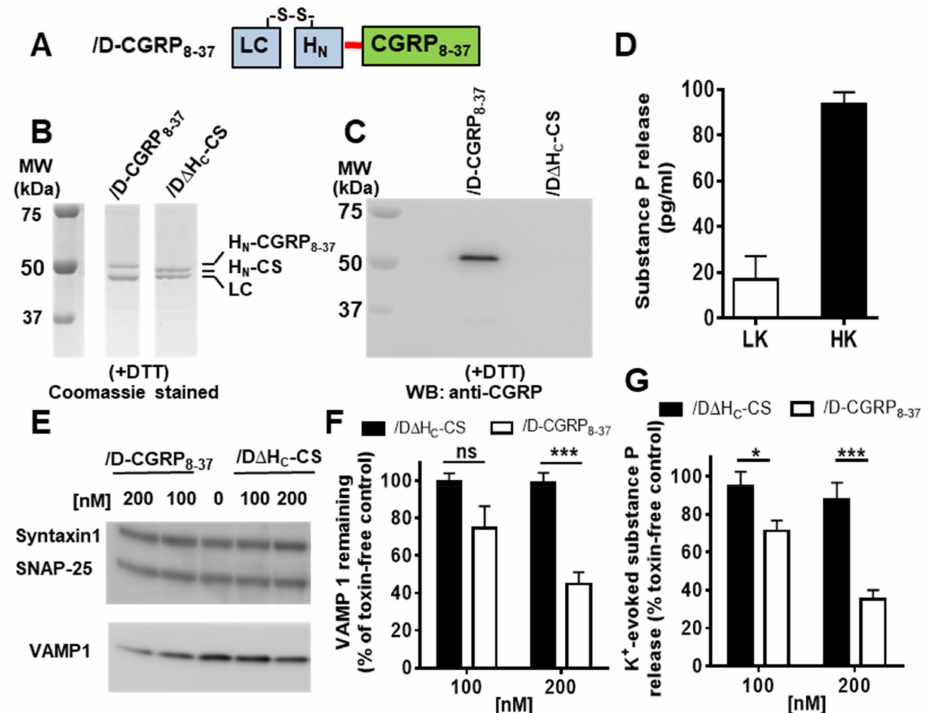
Figure 5. Conjugation of CGRP 8-37 to / D ∆ H C -CS yielded / D-CGRP 8-37 which cleaved VAMP1 and inhibited depolarization evoked substance P release from cultured DRGs. ( A ) Schematic of / D-CGRP 8-37 . ( B , C ) DTT reduced / D-CGRP 8-37 and / D ∆ H C -CS samples were analyzed by SDS-PAGE followed by Coomassie staining ( B ) or by Western blotting with a rabbit anti-CGRP antibody (1:10,000) ( C ). Uncropped original images are shown in Figure S4. ( D ) Depolarization of cultured DRGs stimulated the release of substance P approximately 5-fold over basal release (LK, low potassium; HK, high potassium). ( E ) Representative Western blots showing the cleavage of VAMP1 by / D-CGRP 8-37 compared to / D ∆ H C -CS. Syntaxin1 and SNAP-25 were probed as loading control. ( F ) Intact VAMP1 remaining after incubating with 100 nM or 200 nM of either protein was calculated by expressing the ratio (intensity of VAMP1 / the corresponding internal loading control (Syntaxin1)) as a percentage of the toxin free control sample. ( G ) / D-CGRP 8-37 but not / D ∆ H C -CS attenuated the K + -evoked substance P release when compared to the toxin-free sample. Data plotted in ( D , F , G ) are mean ± S.E.M. ( n = 3). ns: non-significant, * p < 0.05 and *** p <